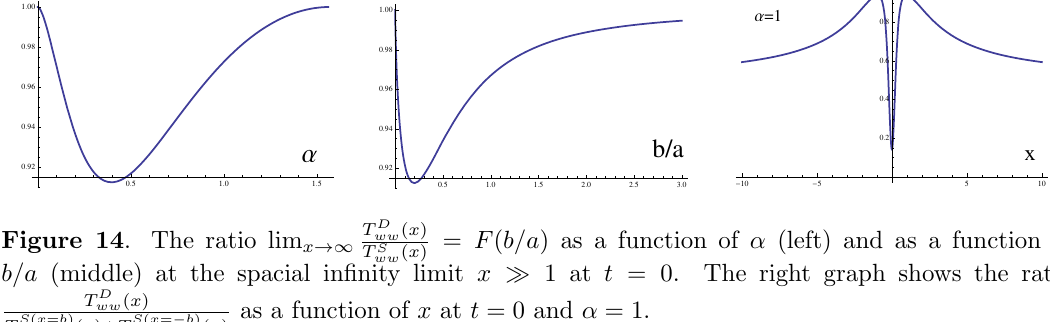
Figure 14 . The ratio lim b=a (middle) at the spacial in(cid:12)nity limit x T D ww ( x ) T S ( x = b )